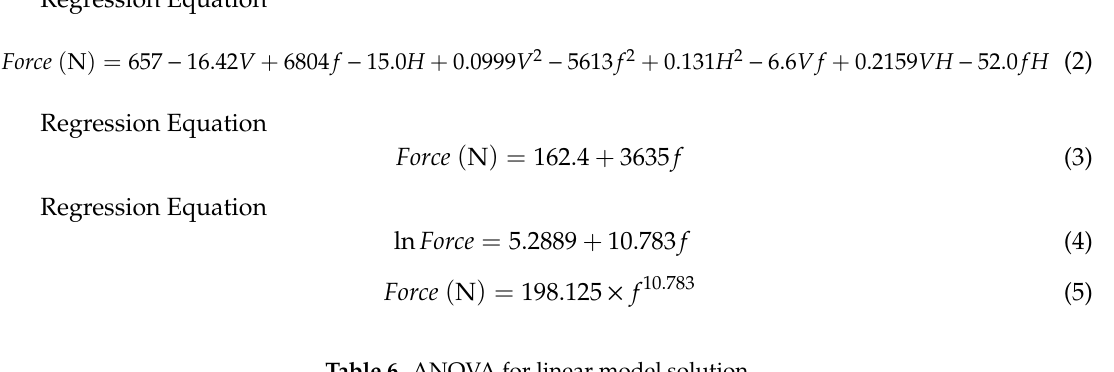
Table 6. ANOVA for linear model